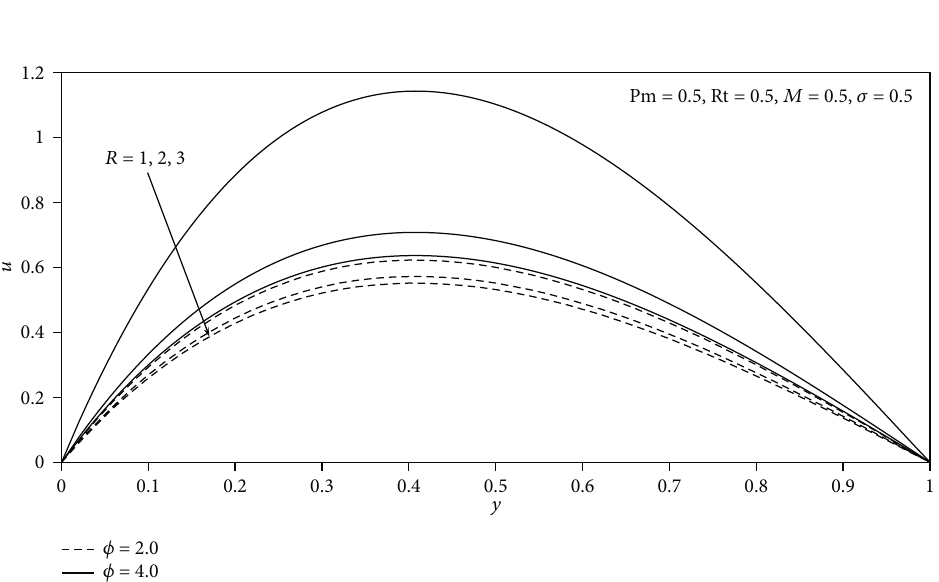
Figure 3: Velocity pro fi les for di ff erent values of R and ϕ